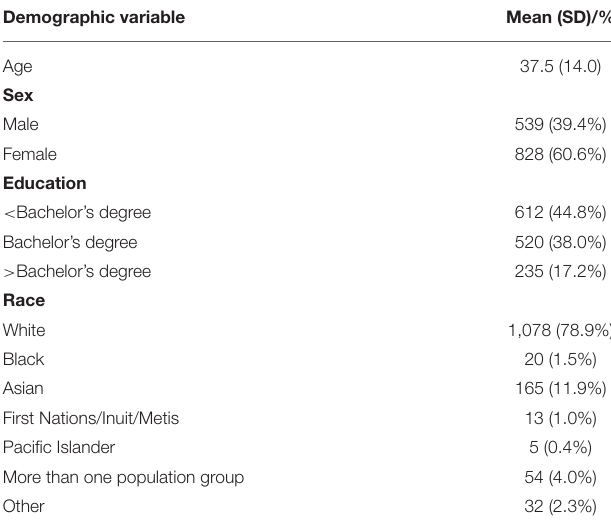
TABLE 1 | Participant demographics ( n =